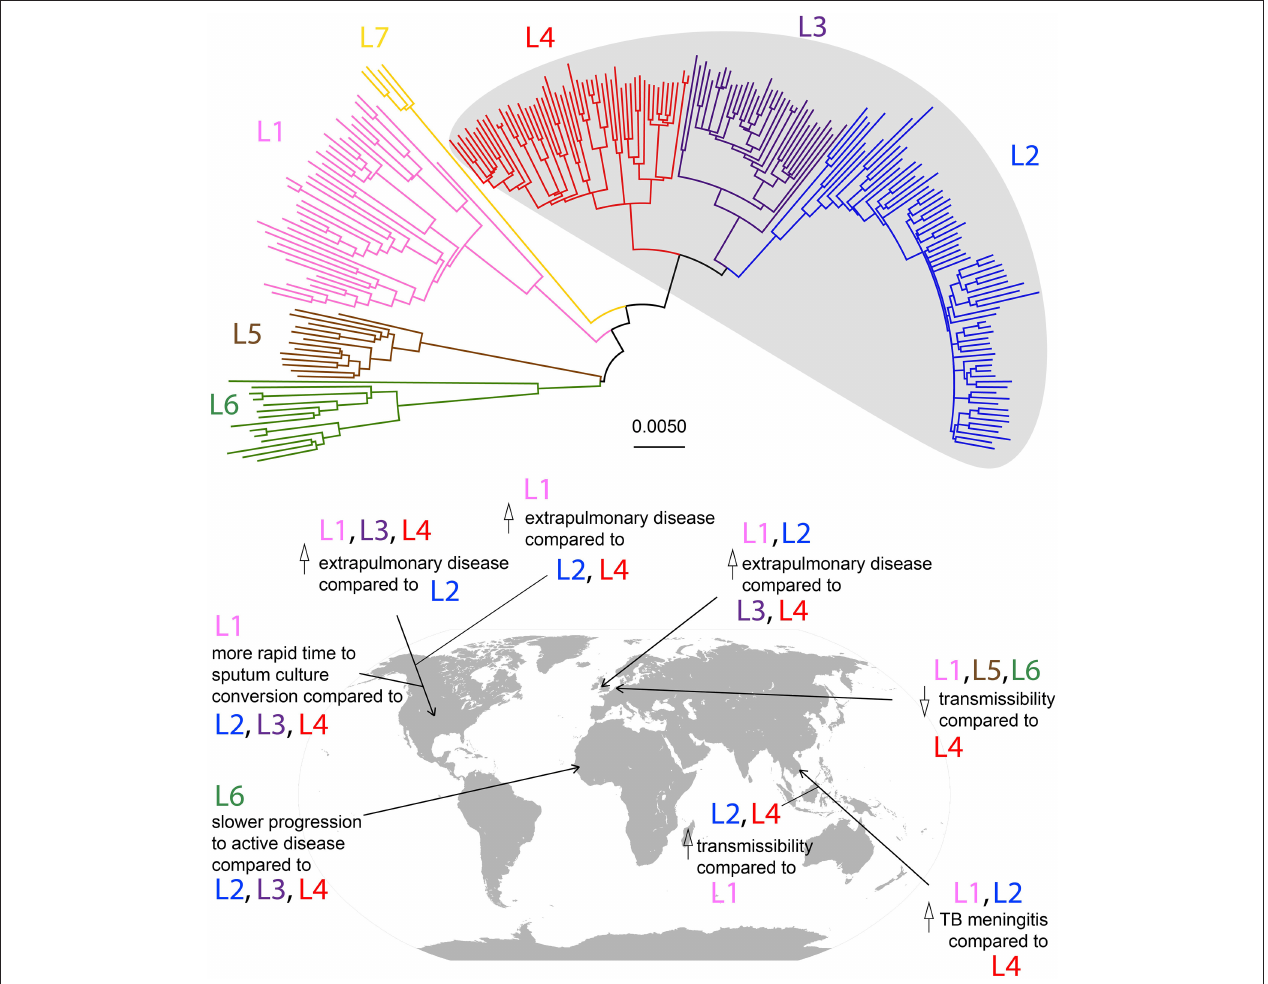
FIGURE 1 | Phylogeny of Mtb lineages and geographic associations of disease characteristics. Neighbor-joining phylogeny based on 35,787 SNPs among 225 strains from Comas et al. (13). Lineages are color-coded according to the scheme described in Bos et al. (16), and modern lineages are shaded in gray. Scale bar represents relative number of substitutions per known variant. Disease characteristic associations with Mtb lineages in geographic locations by studies described in Table 1 are marked on a world